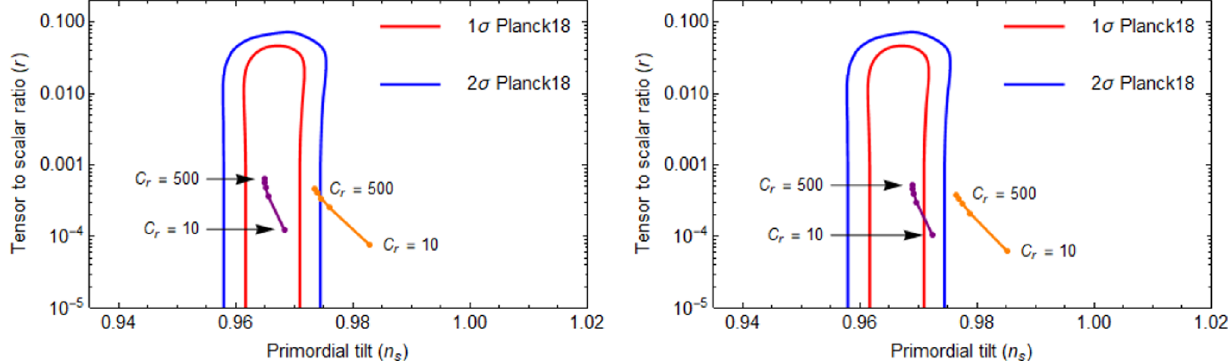
Fig. 2 We compare the theoretical predictions of ( r , n s ) in the strong limit Q >> 1 including the growing mode effect. In each contour, we consider two forms of G ( Q N ) given in Eq. (3.12) for G 1 ( Q N ) (purple curve) and (3.13) for G 2 ( Q N ) (orange curve) with N = 50 (left panel)